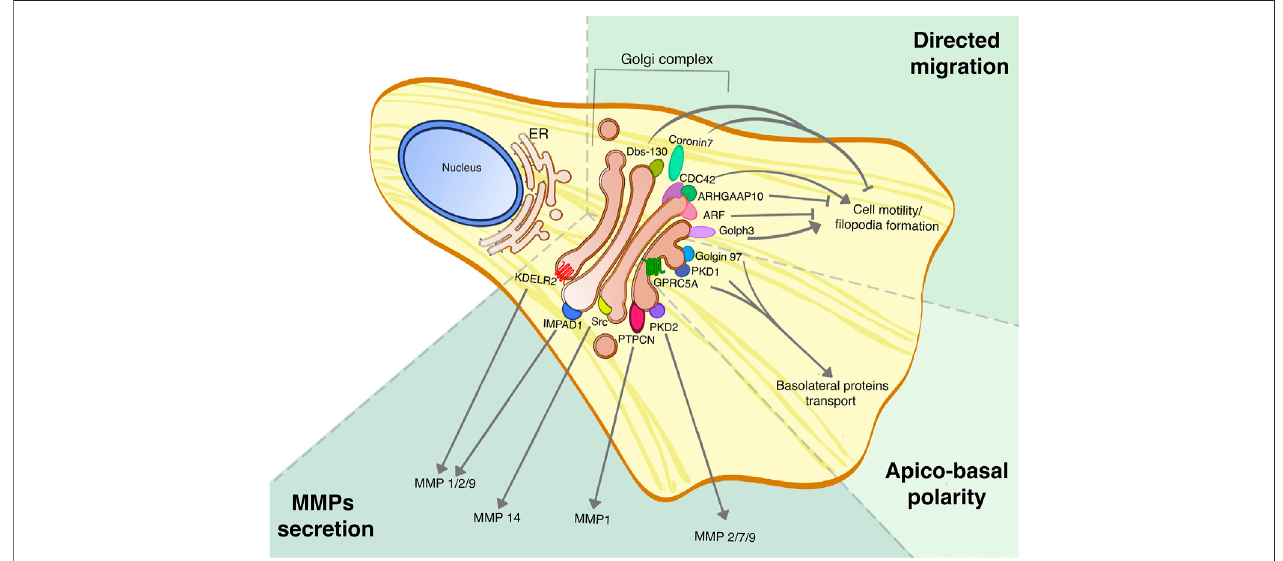
FIGURE2| Golgi proteins roles intumor disseminationand invasion. Golgi proteins areinvolved in multiple processes linked totumor aggressiveness,such asthe secretion of MMPs, cell migration and regulation of apico-basal polarity, and their roles have been assessed in different tumors. This picture summarizes the different Golgi signaling proteins involved in regulating speci fi c MMPs secretion, the Golgi-localized proteins that are part of the CDC-42 complex for directed cell migration, and fi nally the PKD signaling pathway that promotes the maintenance of apico-basal polarity.